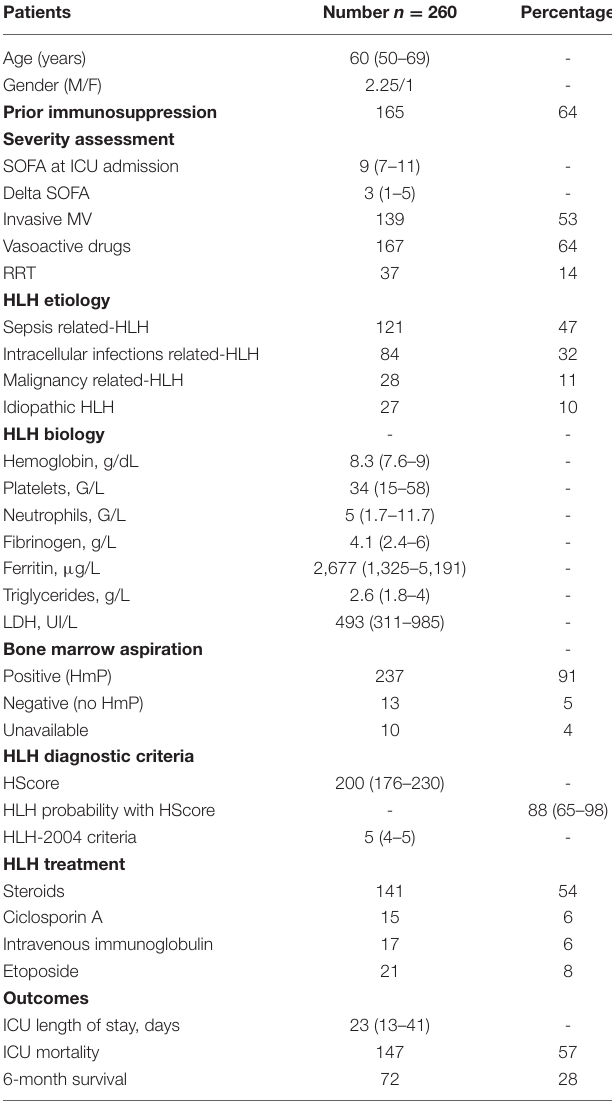
TABLE 1 | Characteristics of the 260 HLH patients in